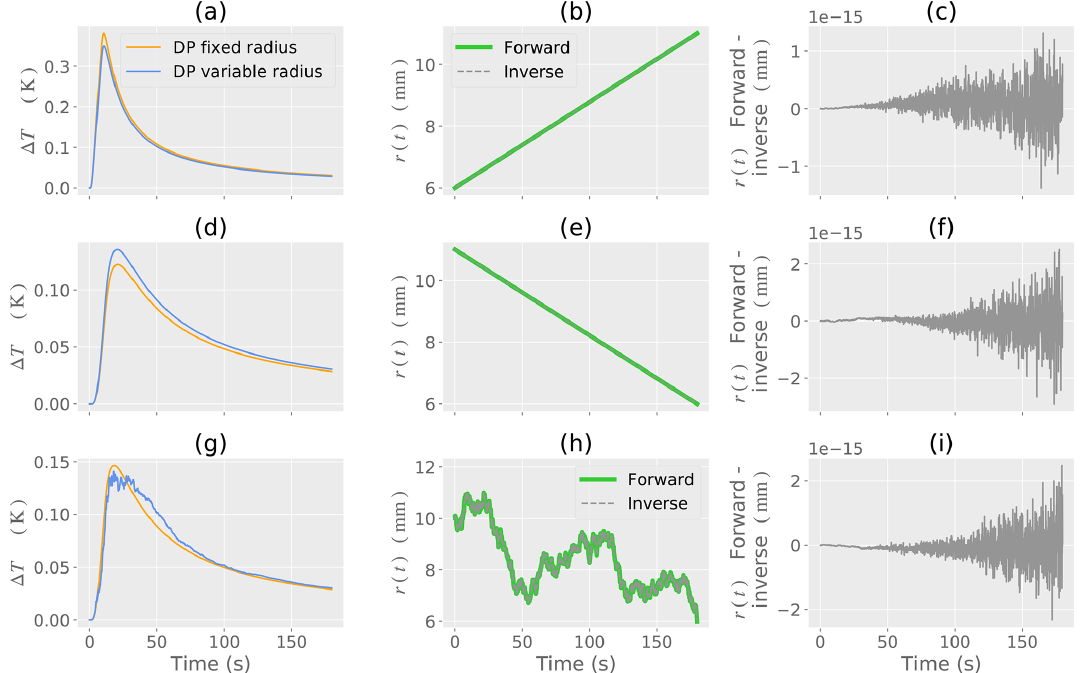
Figure 4. Synthetic example of DP forward and inverse models. ( a , d , g ) DP temperature change (cid:49)T with a fixed and variable radius. ( b , e , h ) Known change in r(t) as a variable radius. The forward and inverse model (reconstruction by signal processing) is shown. ( c , f , i ) Numerical difference between the forward and inverse models. Each row of Fig. 4 corresponds to a numerical experiment with an associated change in r(t) given in the second column ( b , e , h